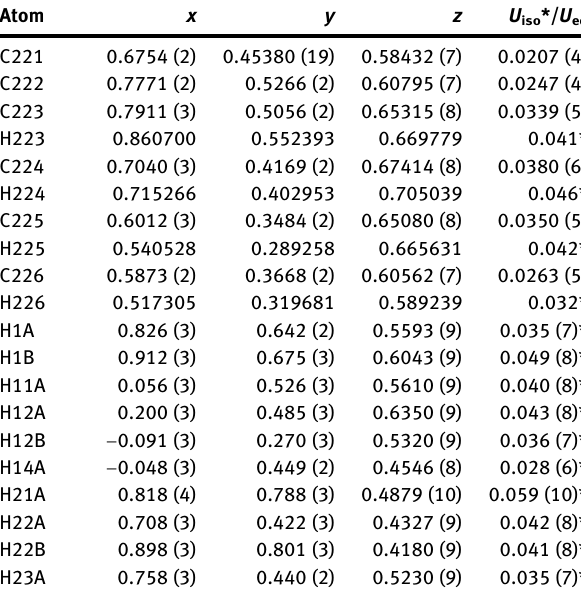
Table  : Fractional atomic coordinates and isotropic or equivalent isotropic displacement parameters (Å 